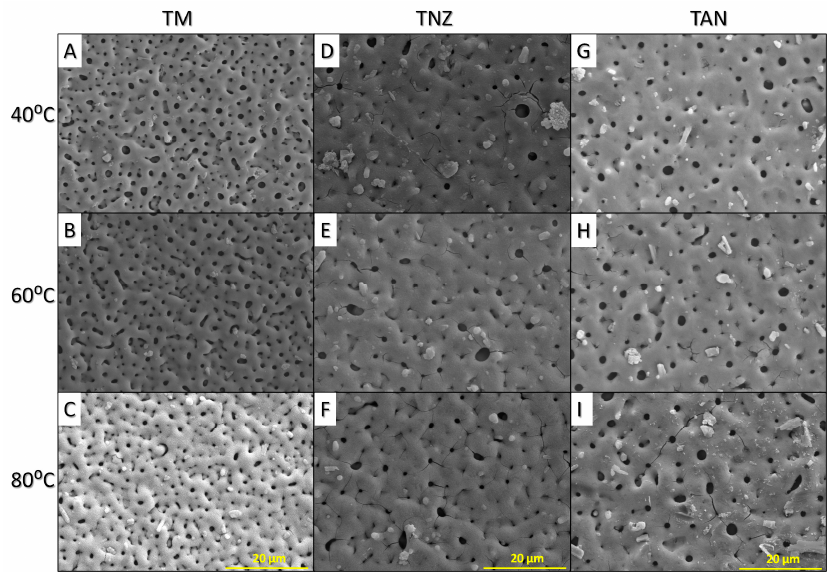
Figure 2. SEM images of the titanium TM ( A – C ), TNZ ( D – F ), TAN ( G – I ) alloy samples after anodization and immersion in 1 M NaOH at various temperatures, for 8 h. (TM: T-15Mo; TNZ: Ti-13Nb-13Zr; TAN: Ti-6Al-7Nb.)